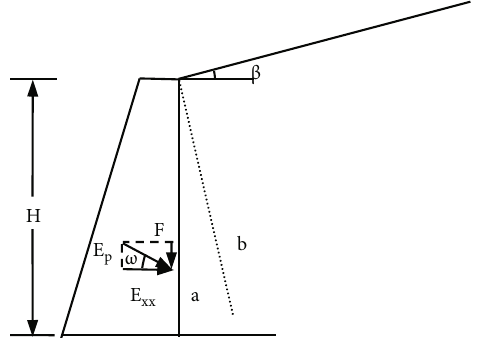
Figure 2: Retaining wall under passive limit